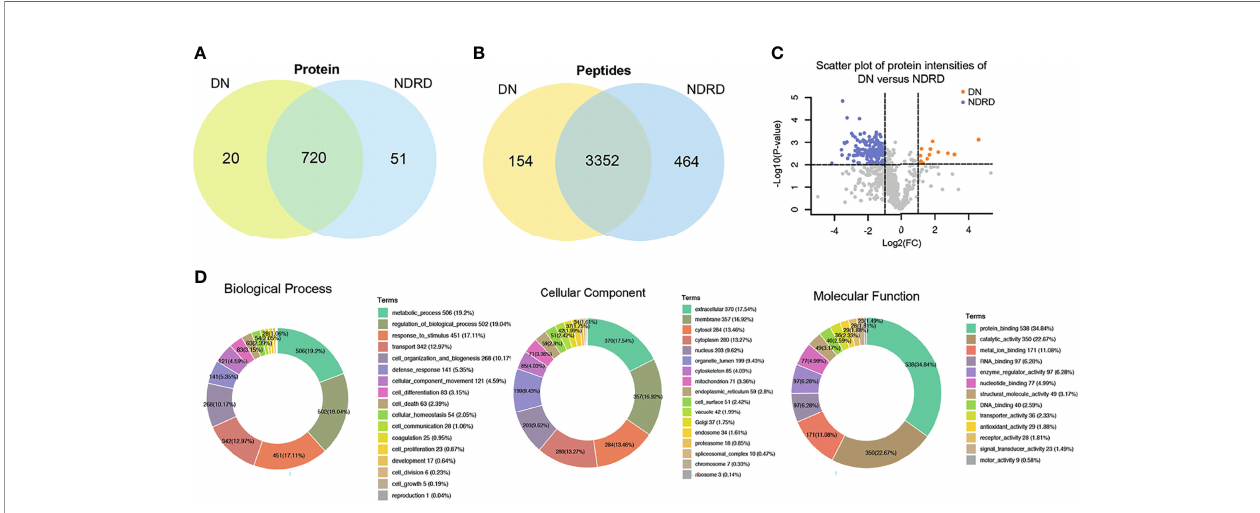
FIGURE 5 | Bioinformatics analysis of isolated glycoproteins from DN and NDRD. (A) Venn diagram of isolated proteins from DN and NDRD using LEL-coupled magnetic particle conjugates. (B) Venn diagram of isolated peptides from DN and NDRD using LEL-coupled magnetic particle conjugates. (C) Scatter plot of protein levels between DN and NDRD. y-Axis correspond to p-values ( − log10) versus protein log2 fold-change (x-axis) in DN/NDRD. Colour indicates upregulation (orange) (fold-change > 2, p < 0.01) and downregulation (blue) (fold-change < 0.5, p < 0.01). Black represents the level of proteins without statistically signi fi cant difference between NDRD and DN. (D) Blast2GO was used to classify identi fi ed proteins into biological process, cellular component, and molecular function. DN, diabetic nephropathy; NDRD, non-diabetic renal disease; LEL, Lycopersicon esculentum lectin.